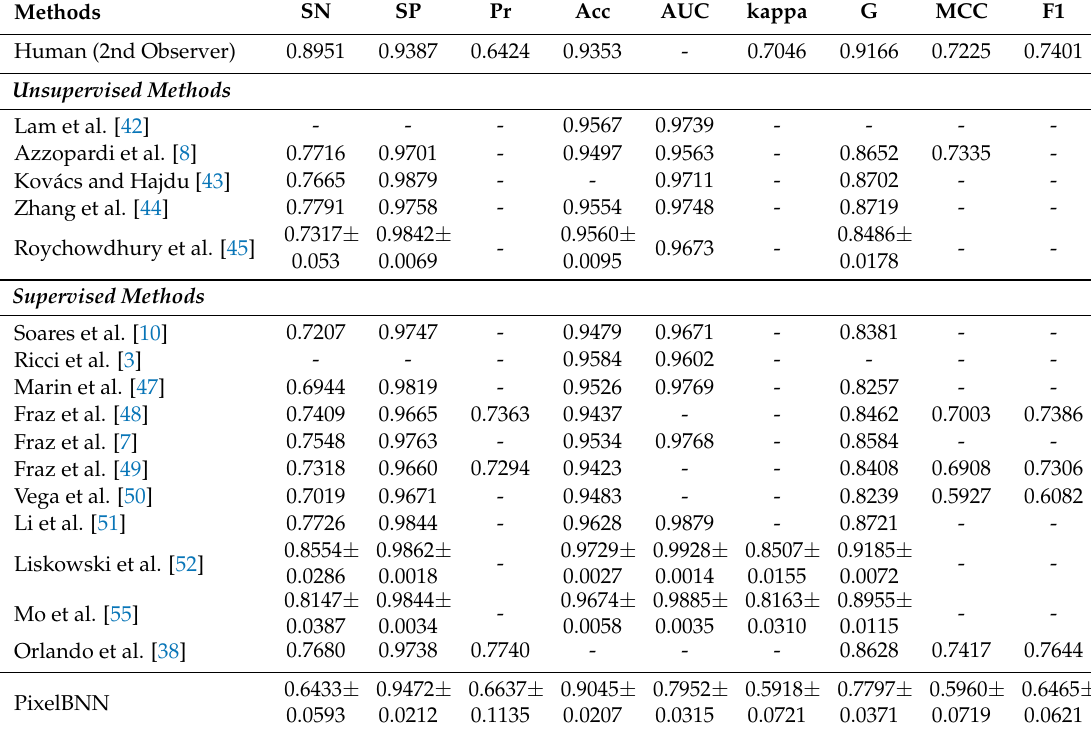
Table 4. Performance comparison for models trained and tested with STARE.